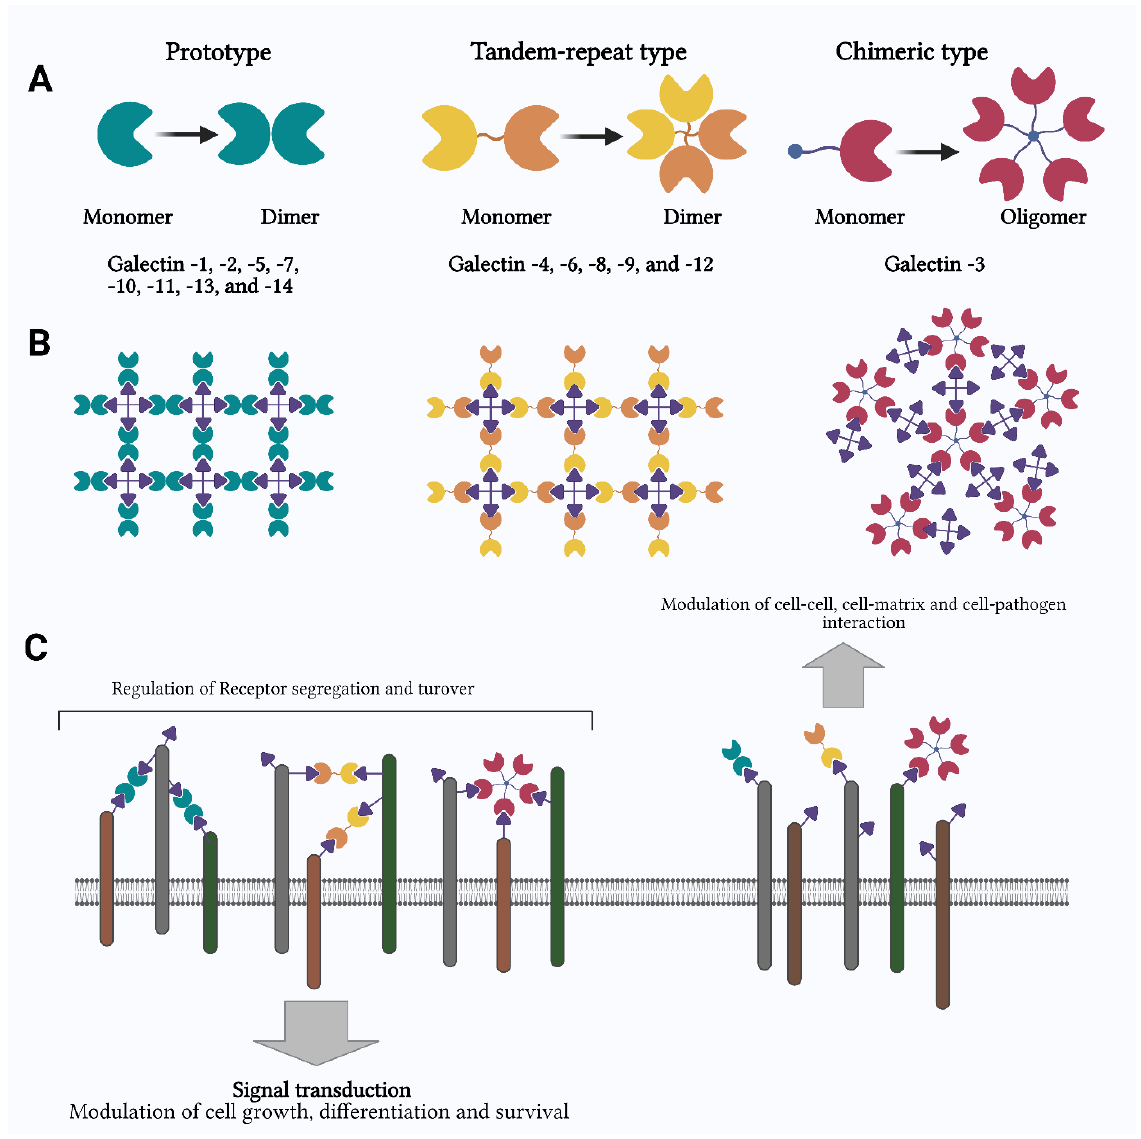
Figure 1. Architectural and functional schematic of galectins ( A – C ).